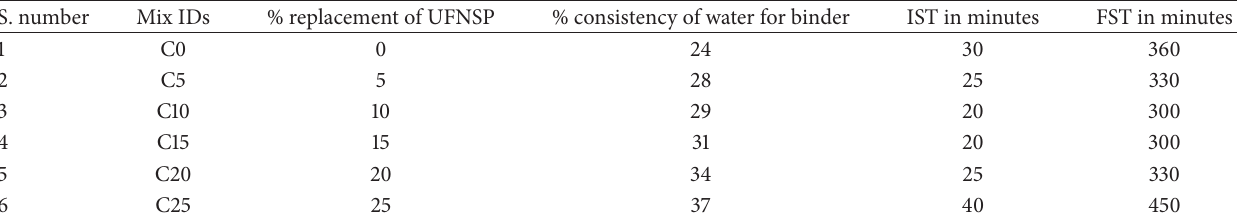
Table 2: Consistency, IST, and FST.